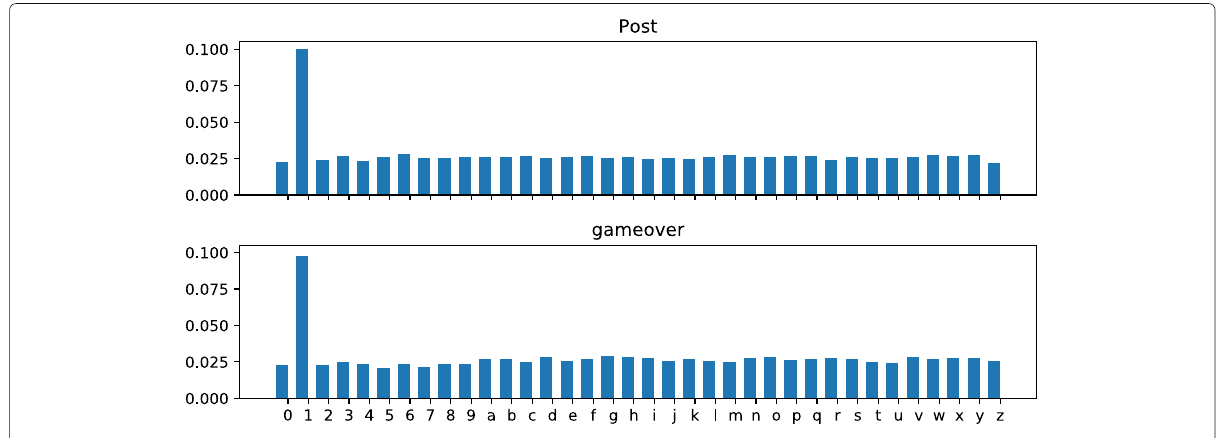
Fig. 5 Unigram distributions for gameover and Post